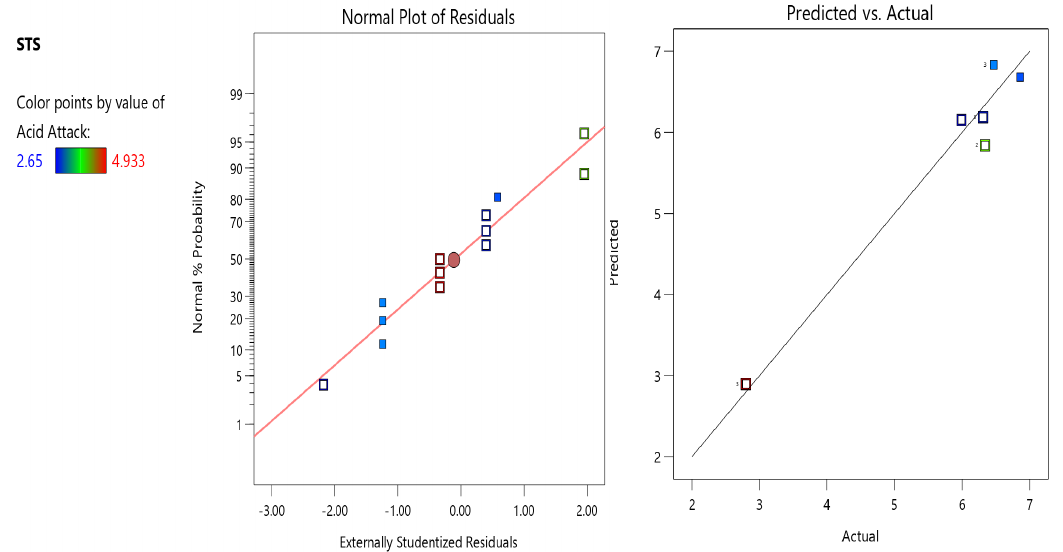
Figure 16. Normal plot for residuals, and actual vs. predicted values for splitting tensile strength.